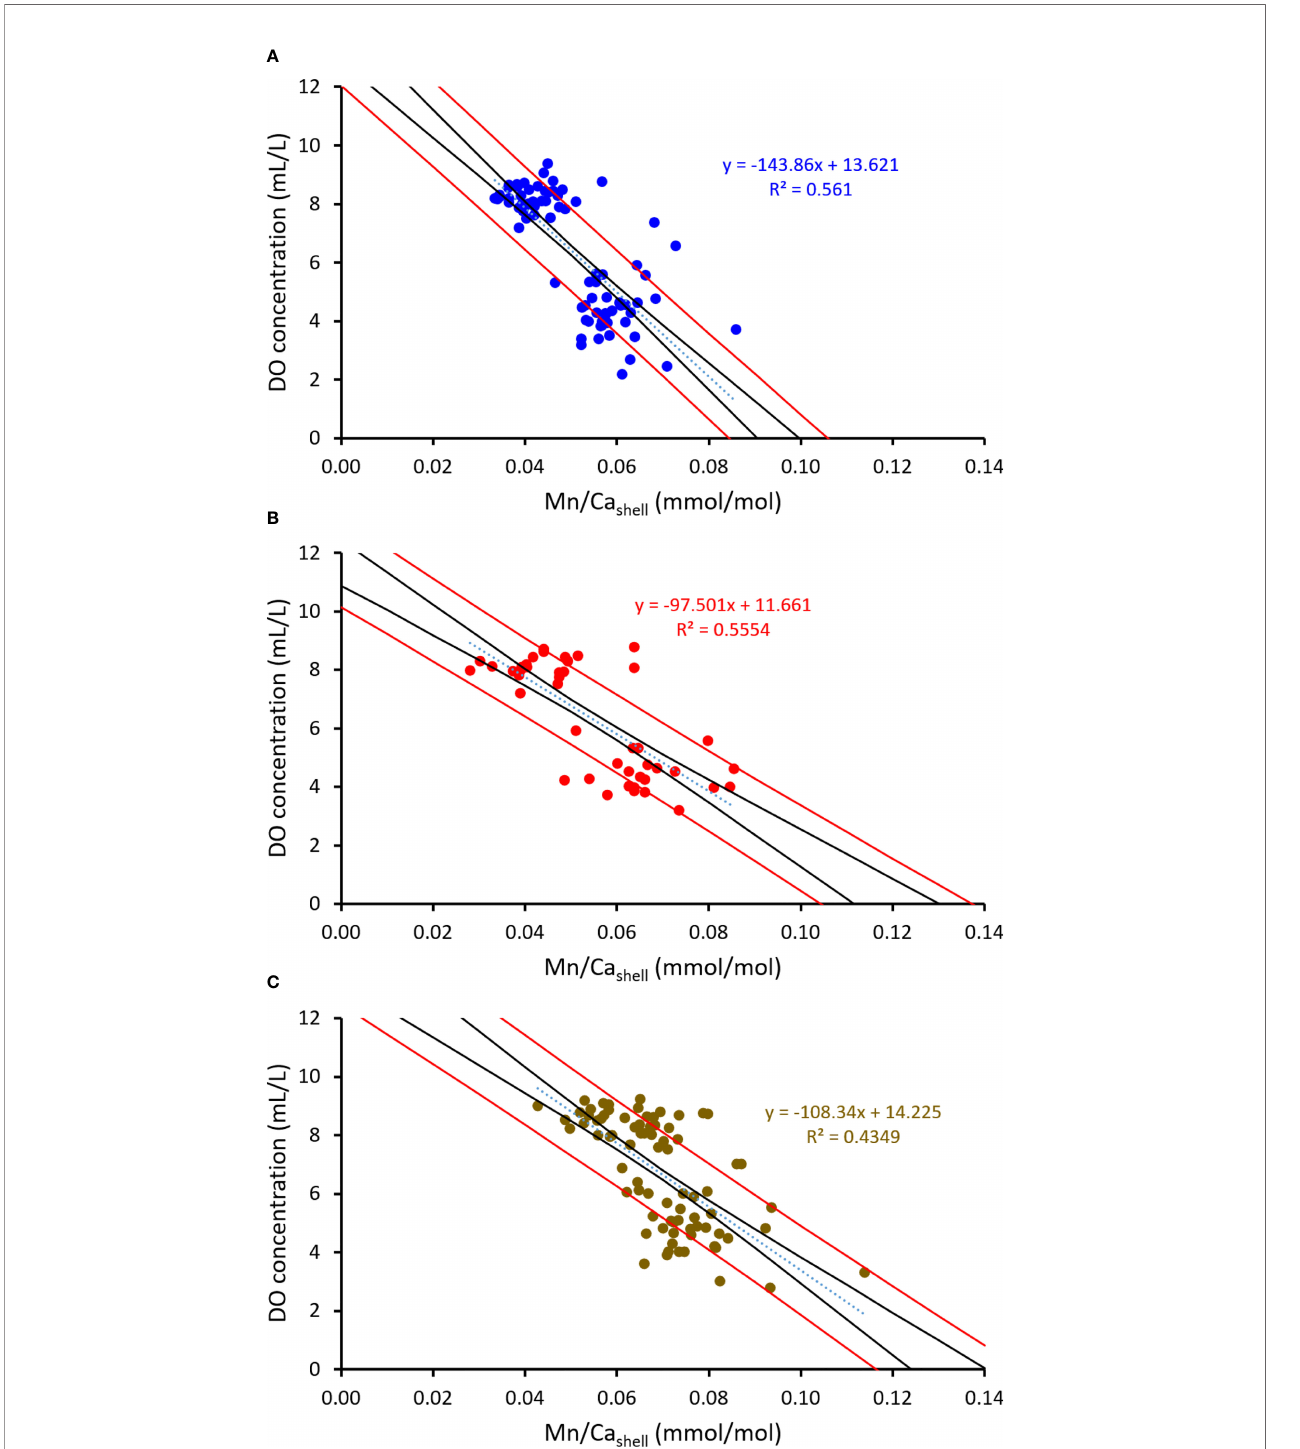
FIGURE 12 | Tentative linear models to predict DO concentration some decimeters above sea fl oor using Mn/Ca shell values of the three studied bivalve species (N = 79 (A) , 44 (B) and 80 (C) ; all p < 0.0001). (A) A. islandica ; (B) A. elliptica ; (C) A. borealis . Black curves = 95% con fi dence intervals of the regression lines; red curves = 1 s prediction intervals. A. elliptica can provide slightly more precise DO data ( ± 1.5 mL/L) than A. islandica or A. borealis ( ± 1.6